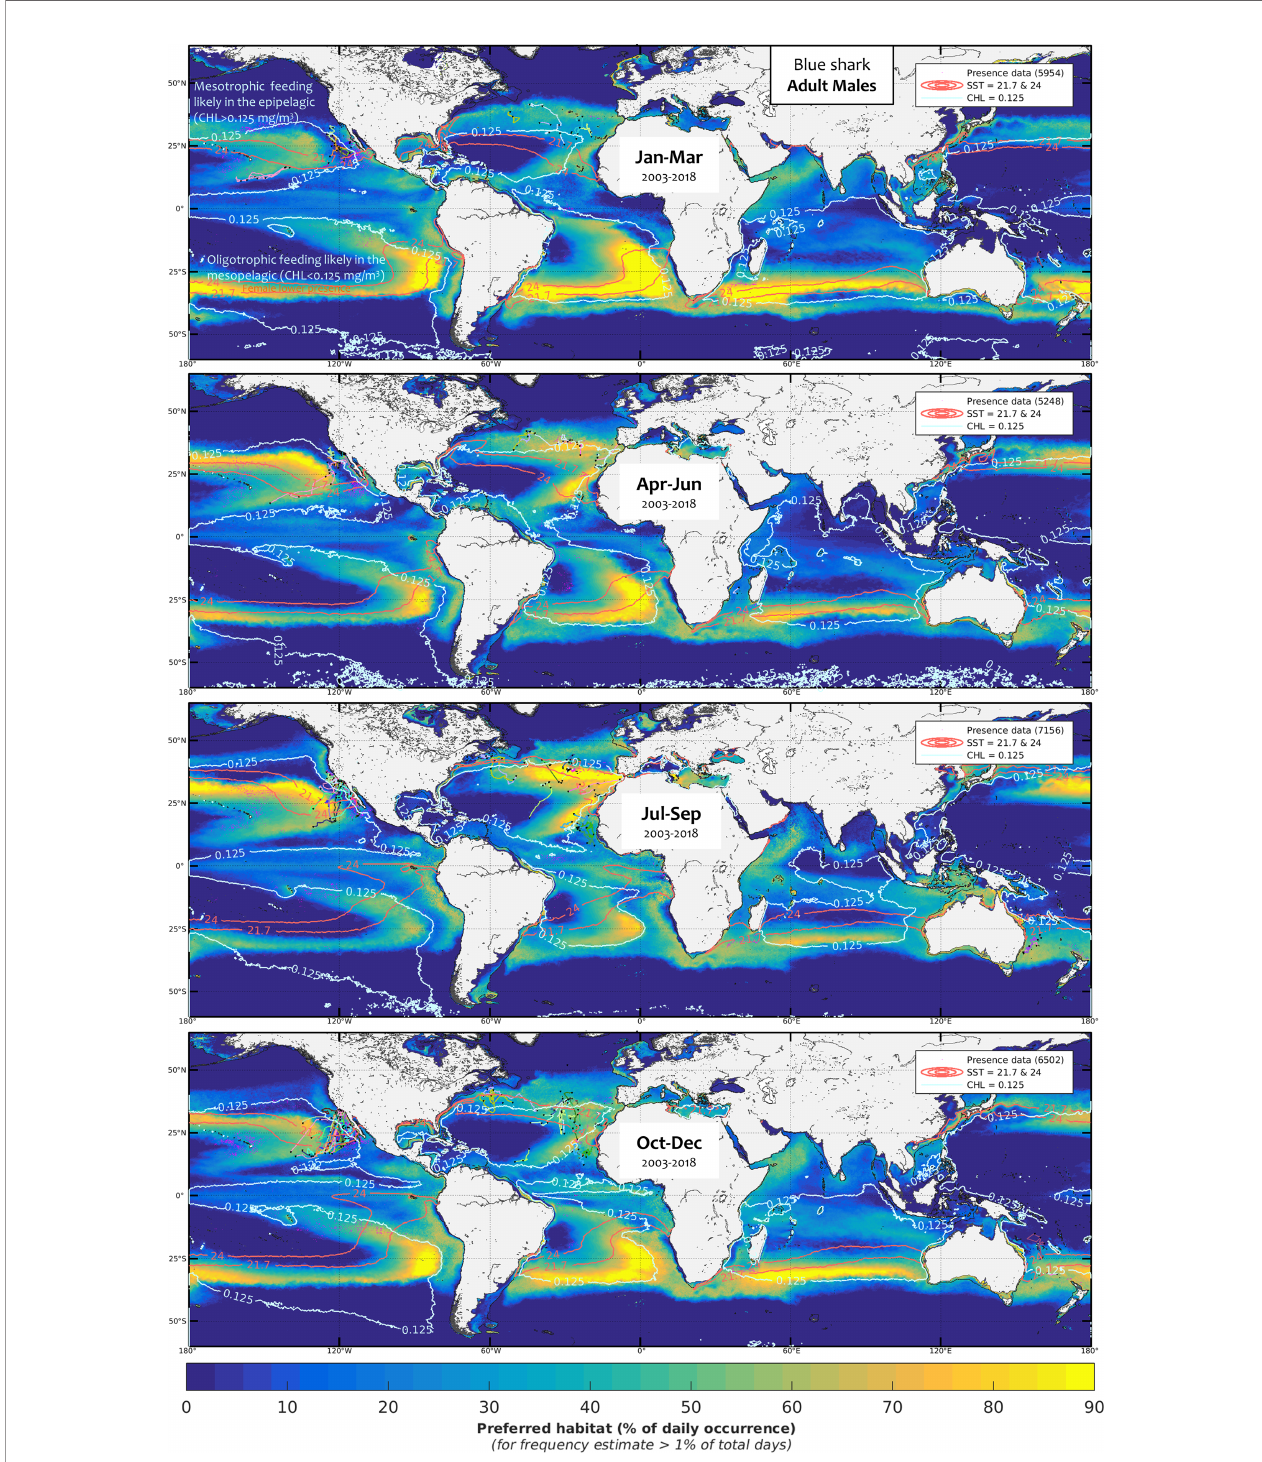
FIGURE 9 | Mean seasonal distribution of blue shark foraging habitat for the adult males (AM, 2003-2018, in frequency of suitable habitat occurrence, %). The chlorophyll-a isocontour of 0.125 mg.m -3 ( CHL min ) separates the mean area of oligotrophic foraging (below this value using mesopelagic micronekton as foraging proxy) and mesotrophic foraging (above this value using productivity fronts). Presence data (calibration and validation) are represented as pink dots for observer data and colored line transects for electronic tagging data (start and end of months are shown by a black star). The SST isocontours of LJF avoidance (21.7°C and 24°C), slightly larger than for AF, allow evaluating the potential lack of habitat overlap with